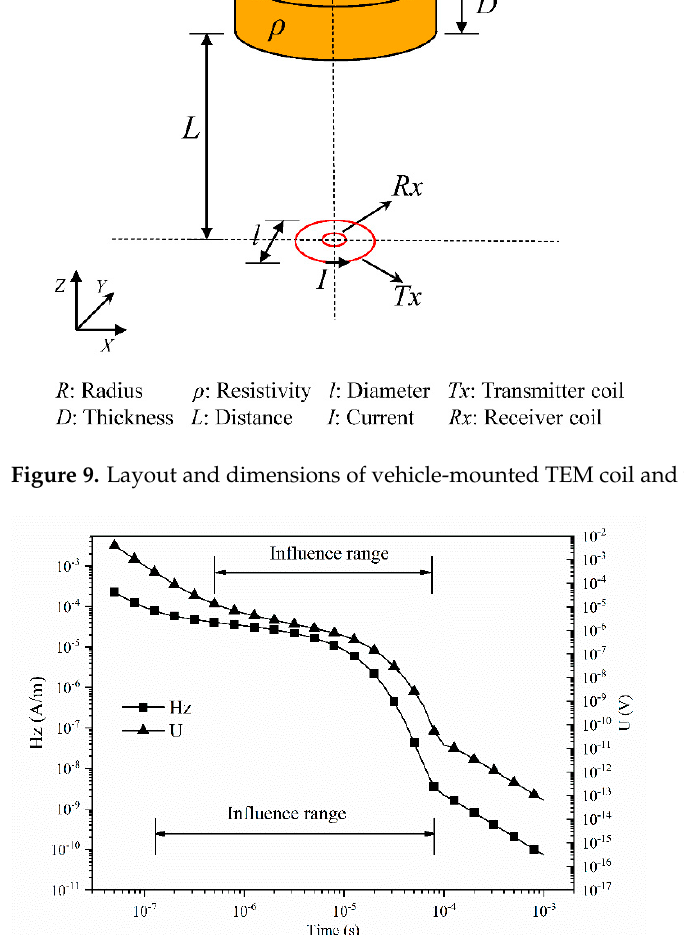
Figure 10. Response curve under the condition of three-dimensional inhomogeneous whole-space.